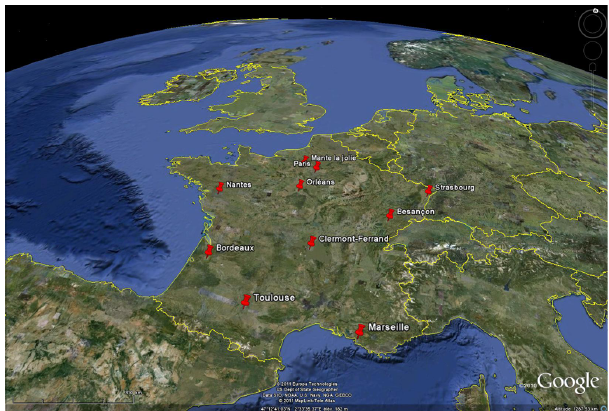
Fig. 1. Locations of the 10 French cities on Google